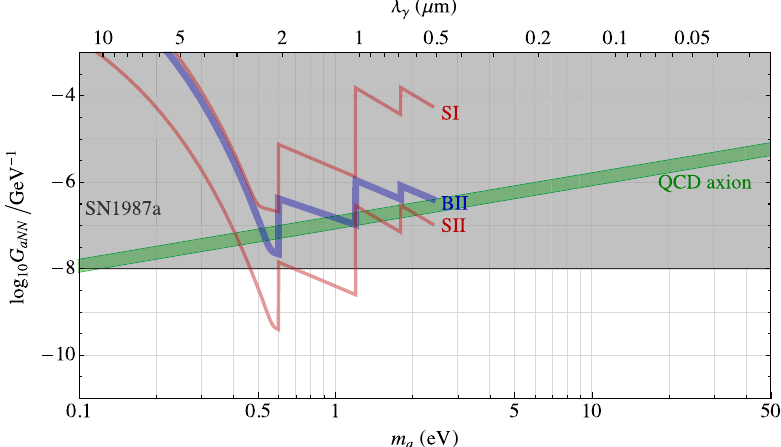
FIG. 12. Reach for the pseudoscalar coupling G (thick blue band), SI, and SII (thin red bands). The green band indicates the typical mass-coupling relation between m 1 =f for the QCD axion. The gray exclusion region is a “ robust ” bound set by a combination of the neutrino burst duration of SN1987a a and null observations of axion scattering events in water Č erenkov detectors after the same supernova.